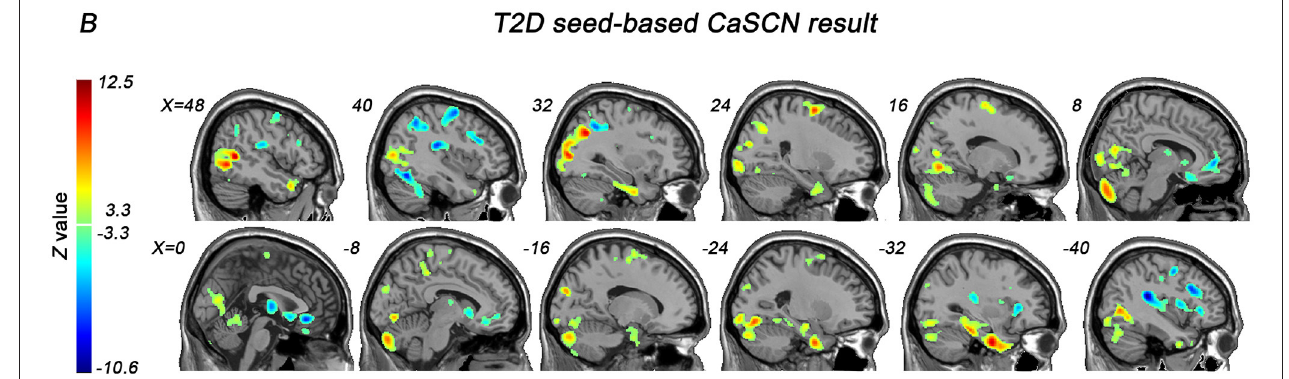
FIGURE 2 | The right temporal pole-based CaSCN analysis results (GRF correction, voxel-level p < 0.001, cluster-level p < 0.01).